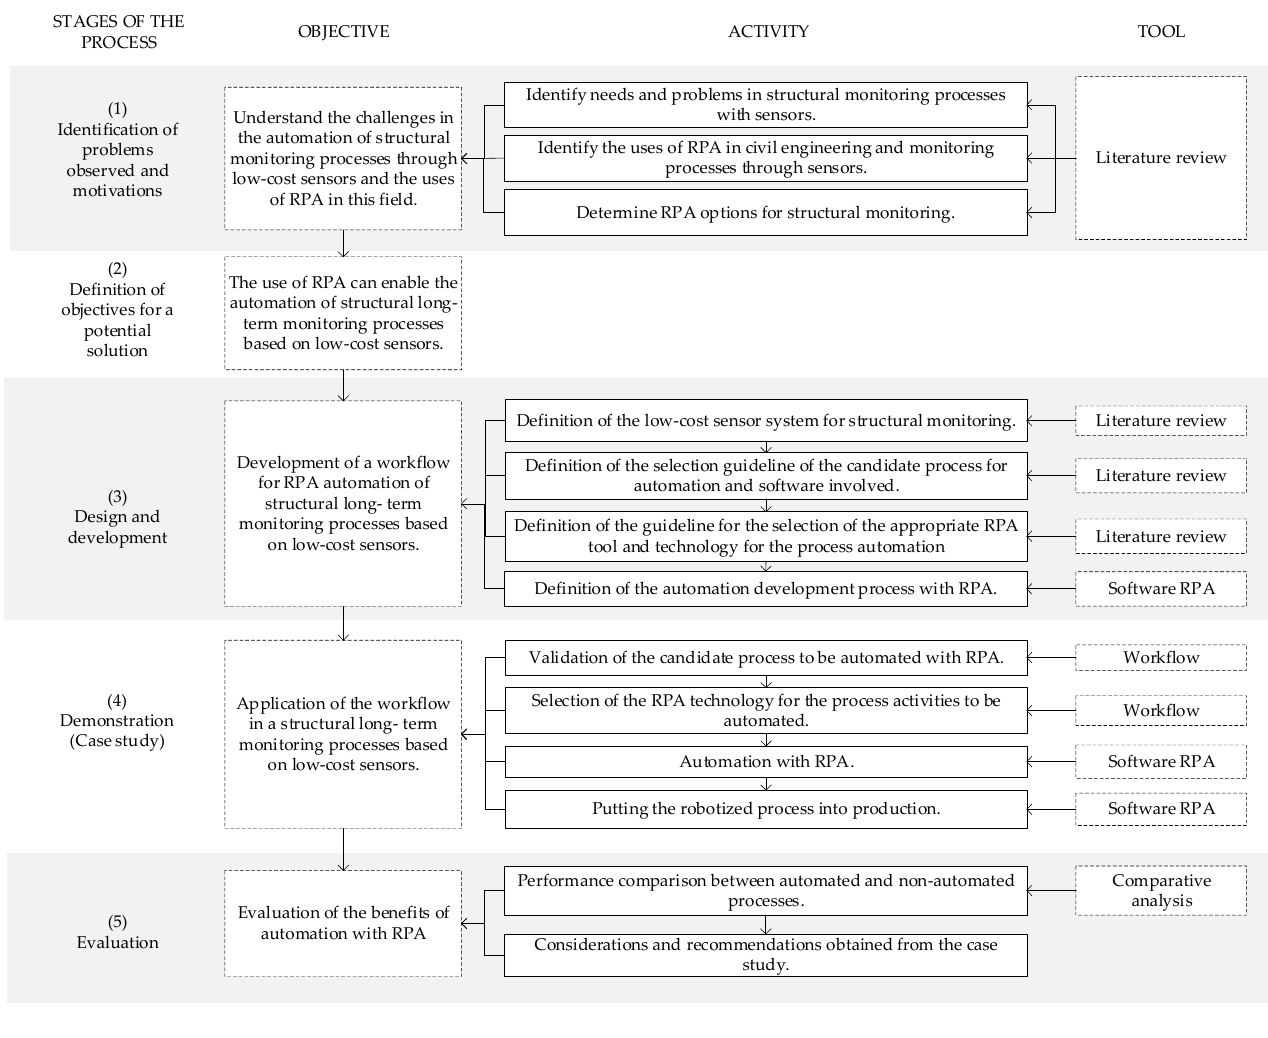
Figure 1 . Research